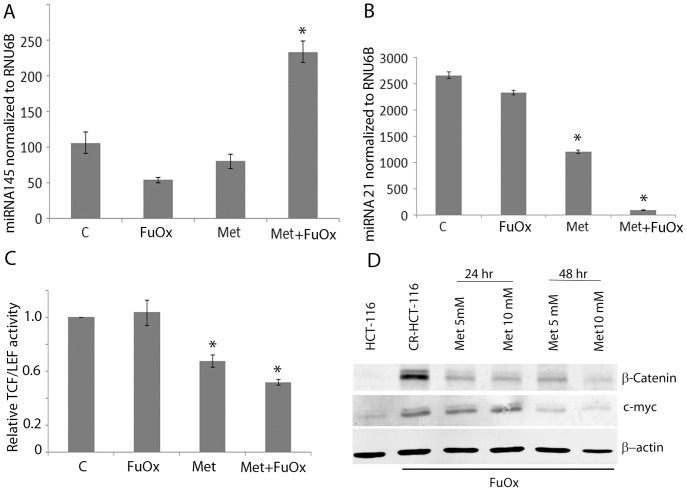
Quantitative real-time PCR showing the expression of miRNA145 (A) and miRNA21(B) normalized to RNU6B in metformin and/or FuOx treated CR HT-29 cells.C: metformin/FuOx treatment of CR HCT-116 cells inhibits transcriptional activity of TCF/LEF. D: Western blot analysis shows a reduced expression of β-catenin and c-myc in metformin/FuOx treated CR HCT-116 cells. β-actin was used as loading control. * p<0.05.